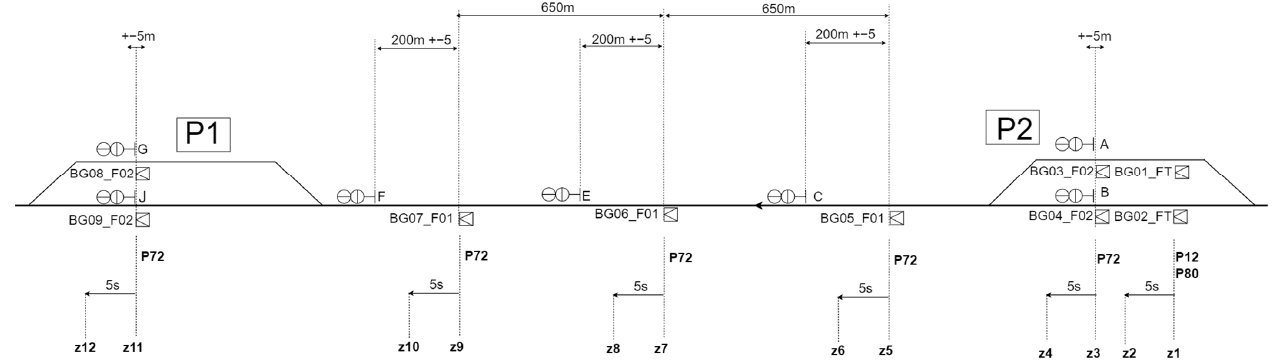
Figure 7. Con fi guration of the track layout and the functional infrastructure necessary for the implementation of the exemplary operational scenario.